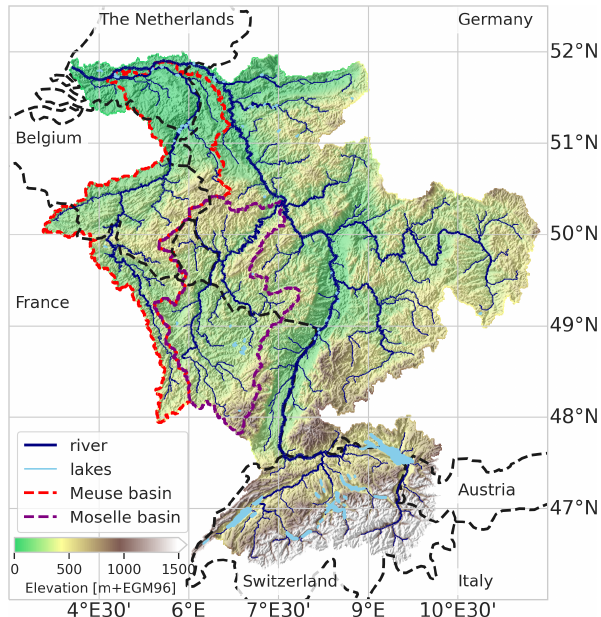
Figure 3. Study area. Rhine basin with average elevation, rivers and basin outlines based on the MERIT Hydro IHU 30arcsec dataset (this paper); lakes are derived from the HydroLAKES dataset (Mes- sager et al.,